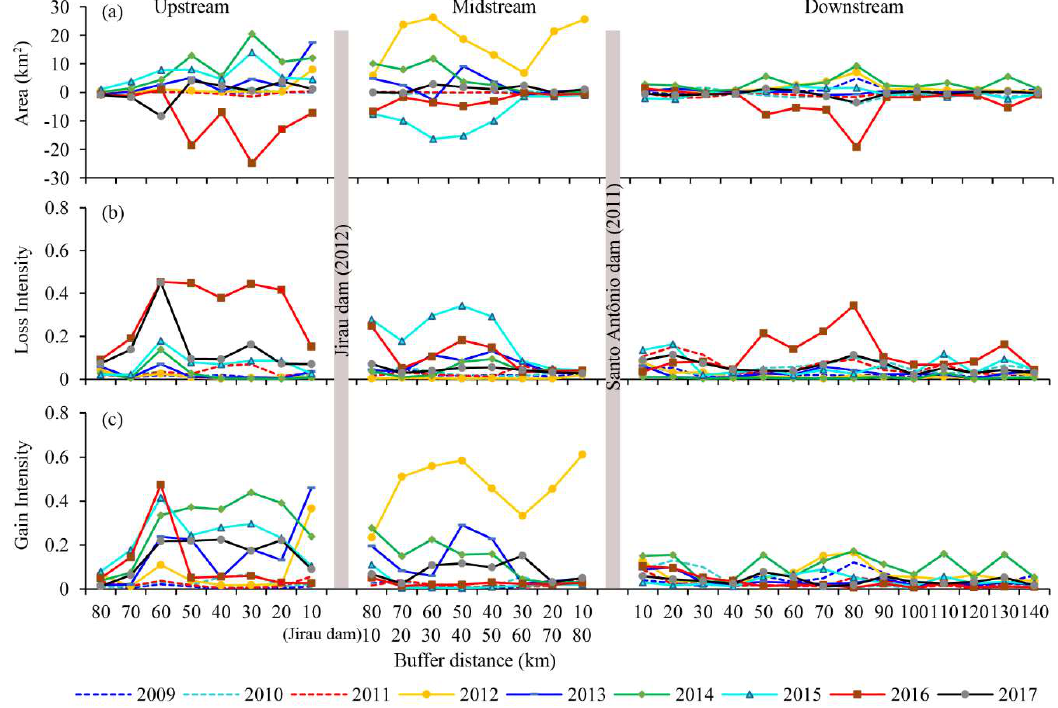
Figure 9. ( a ) Water area net change; ( b ) Loss intensity; ( c ) Gain intensity in different buffer zones from